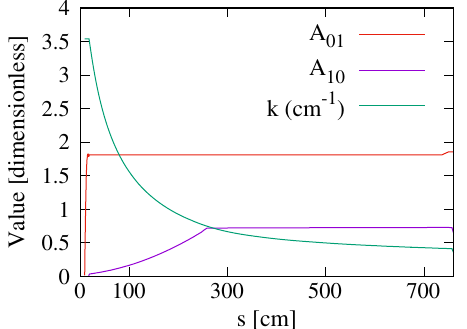
FIG. 2. ISAC-RFQ parameters A 01 (red), A 10 (purple), and k (green) used for TRANSOPTR simulation. The parameters A 01 and A 10 are dimensionless, while k is in cm − 1 . A radial matching section, starting 8.88 cm after the RFQ vacuum tank wall, occupies the first 8 cm of the vanes, followed by a transition cell and 195 accelerating cells. A high-energy transition cell finally gives way to a short unmodulated vane segment at the high energy